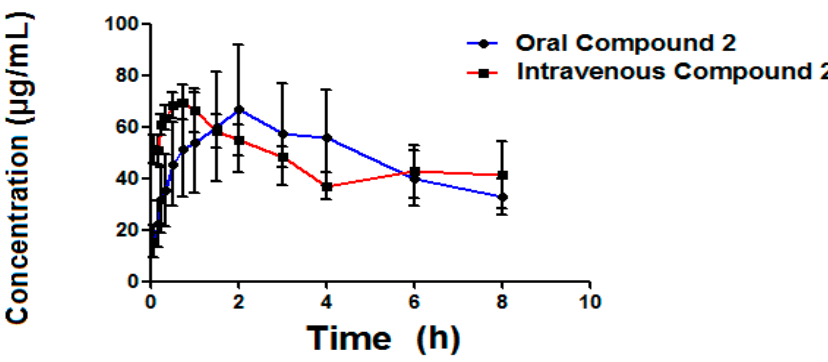
Figure 8. The Compound 2 plasma concentration ( μ g·mL − 1 ) time profile obtained oral and intravenous in Wistar rats, mean ± SE ( n = 6), respectively.